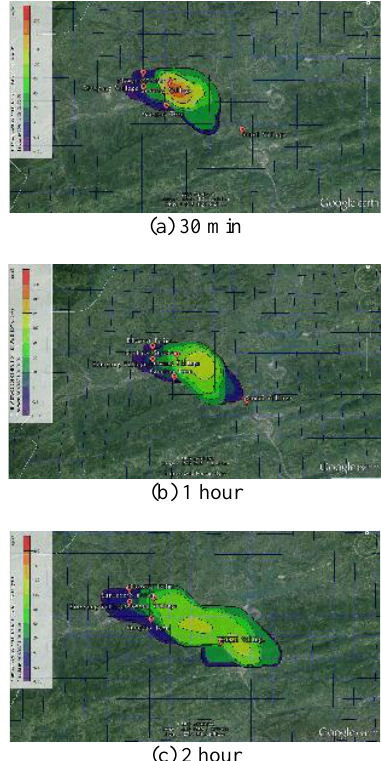
Figure 6. Toxic gas concentration distribution